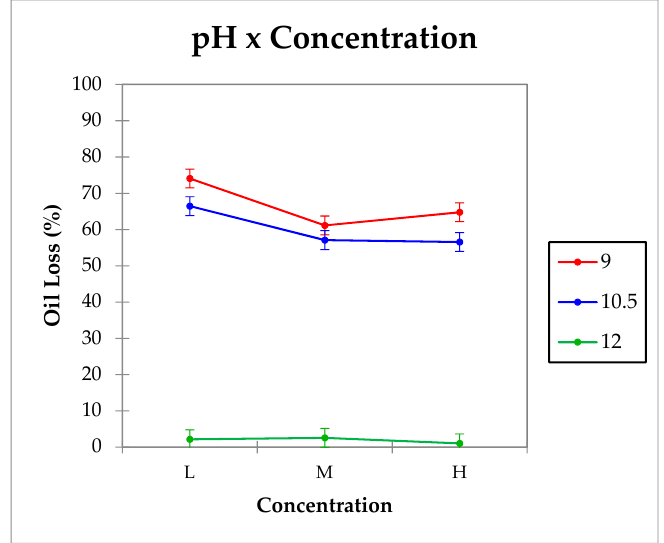
Figure 4. Emulsions oil loss interaction graph. Figure 5. The top layer corresponded to oil, middle layer to the emulsion, and bottom layer to the aqueous phase. Increasing the pH of the medium increased the stability; this which produced higher repulsions among droplets as discussed by Vélez-Erazo et al. [36].